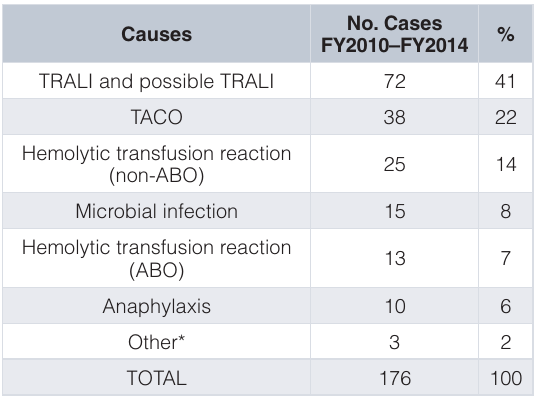
Table 2. Transfusion fatalities reported to the Food and Drug Administration in the United States from fiscal year (FY) 2010 to FY2014 5 .